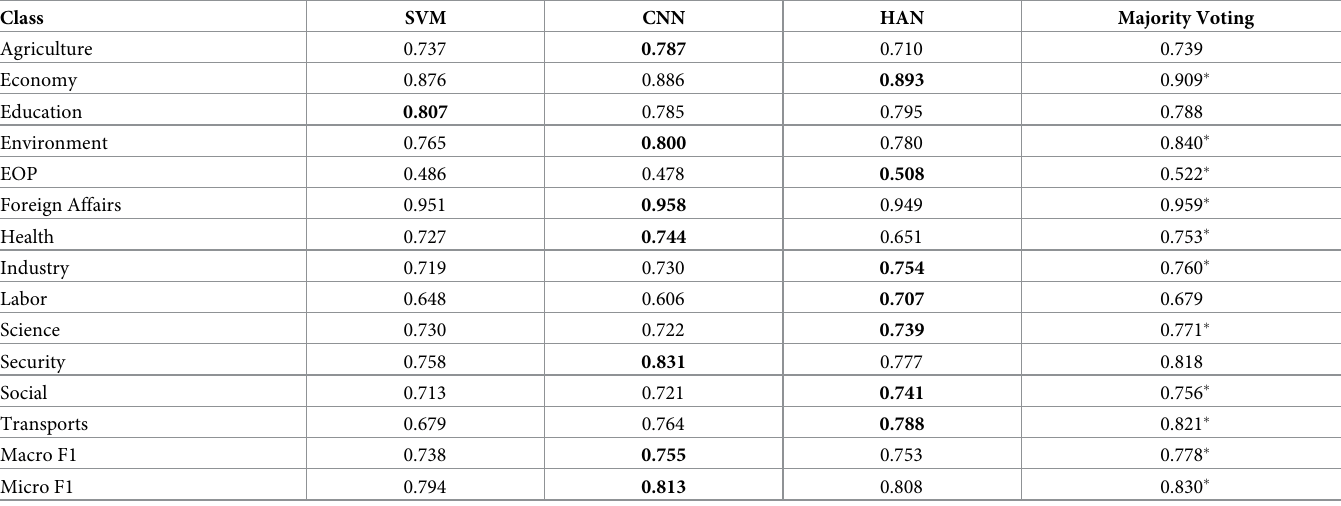
Table 7. F1-score for the cabinets-based taxonomy models.